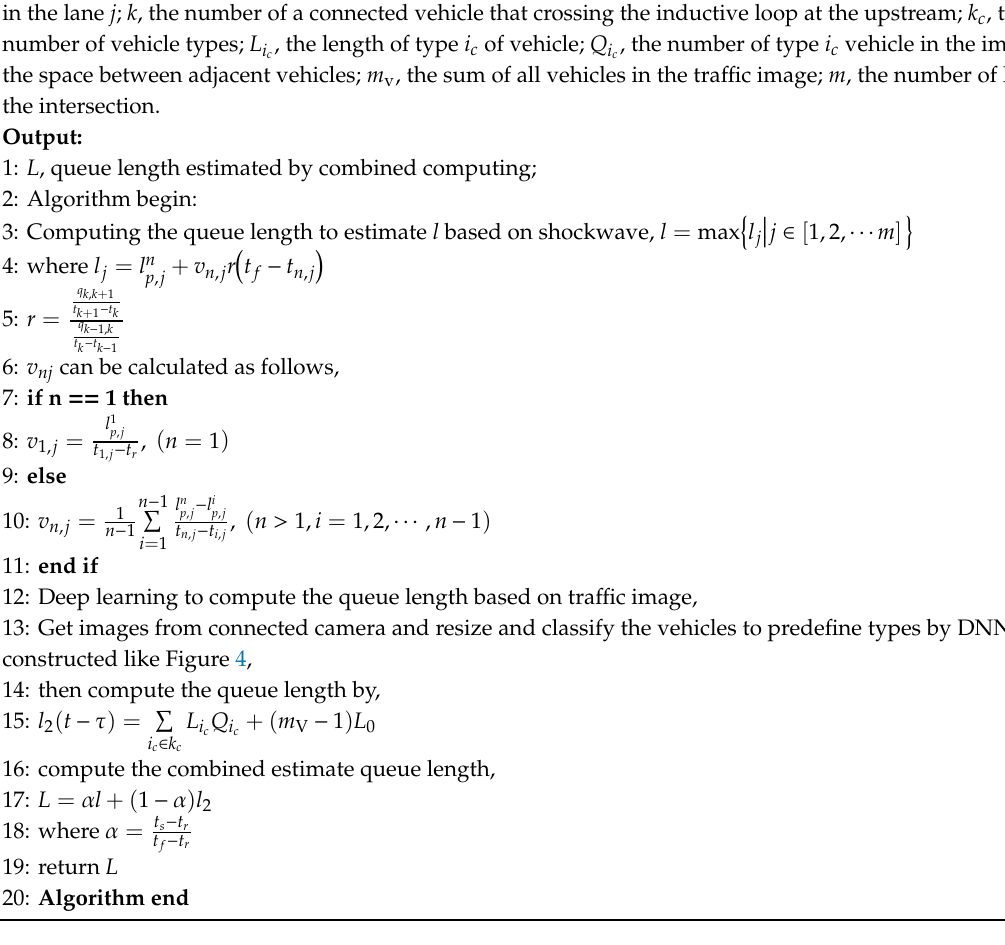
Algorithm 1 Queue Length Estimate Algorithm at